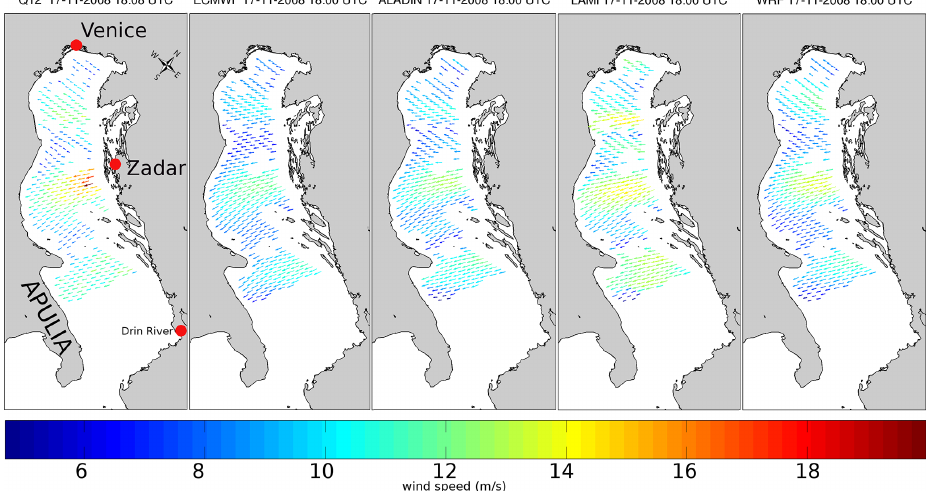
Figure 1. Sea surface wind fields on 17 November. From left to right: the scatterometer pass at 18:08 UTC, and the models wind fields (ECMWF, ALADIN, COSMO-LAMI, WRF) at 18:00 UTC. The maps are rotated 40 ◦ clockwise. The colourbar corresponds to the wind intensity, in ms − 1 , of the vectors plotted in the maps. The first map on the left shows also the geographic positions of Venice (Italy), Zadar (Croatia), the Drin River (Albania) and Apulia region (Italy). The title of the fourth map from left should be read